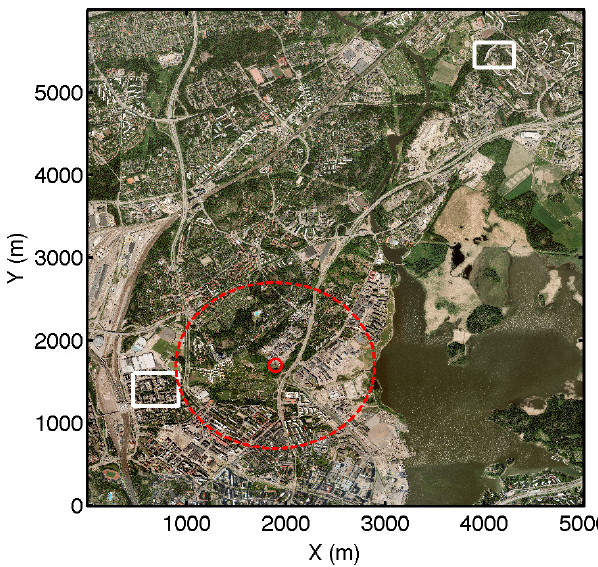
Figure 1. Aerial photograph of the measurement locations in Helsinki. Red dot is the SMEARIII-Kumpula site (Ku). The red dashed line is the 1km radius circle that the surface cover frac- tions are calculated for, and the white squares show the approxi- mate locations of the catchment areas (Pa left side and Pi top right). © Kaupunkimittausosasto, Helsinki,